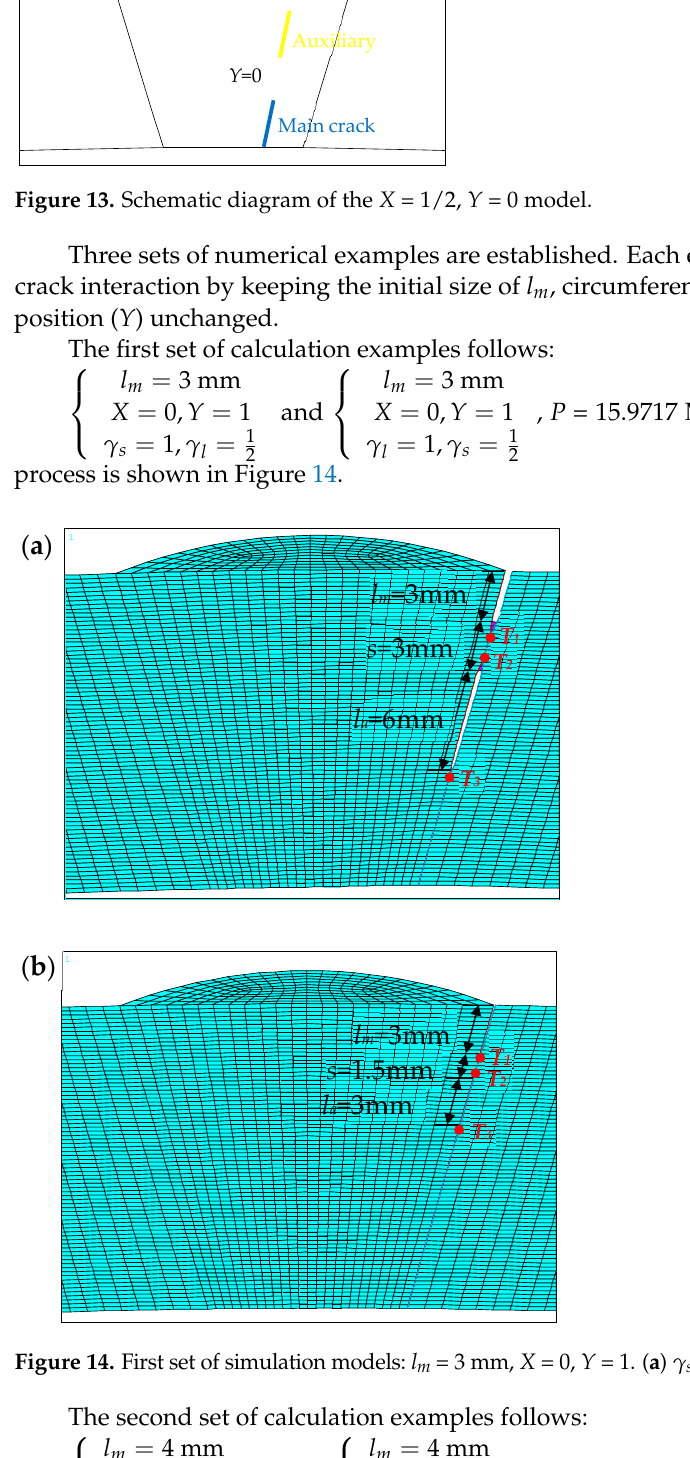
, P = 13.602 MPa, the crack propagation